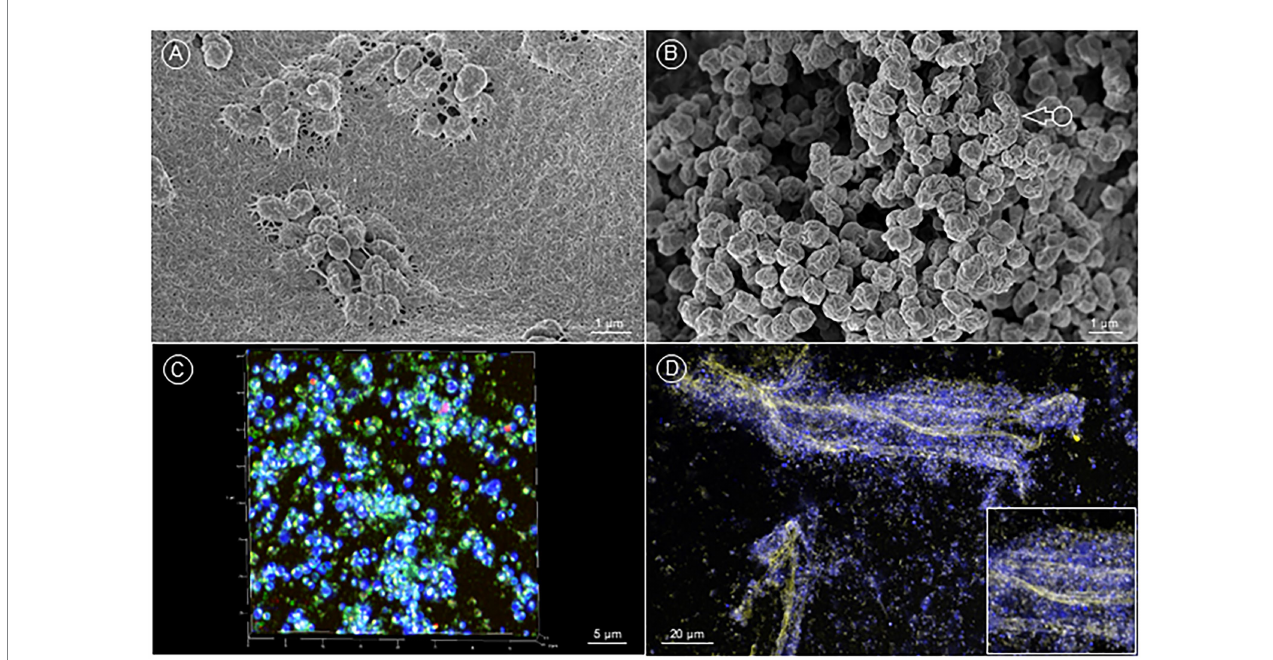
FIGURE 1 In vitro formation of F. tularensis biofilm. (A) (SEM image) Fth grown on collagen coated PE filter on MTK agar plates inoculated with 10 2 bacteria/filter. Plates were incubated at 37 ° C with 5% CO 2 . Fth formed biofilm with a dense, fibrous extracellular matrix. (B) (SEM image) Fth biofilm, grown on a Thermanox ™ coverslip for 4 weeks showing the characteristic crumpled morphology (arrow). (C) (CLSM image) 3D projection of a Fth biofilm stained with DAPI (dsDNA), Sypro® Orange (proteins) and Nile Red (neutral lipids). (D) Fth biofilm with plaited strands of eDNA (yellow) and associated F. tularensis bacteria cells (DNA: